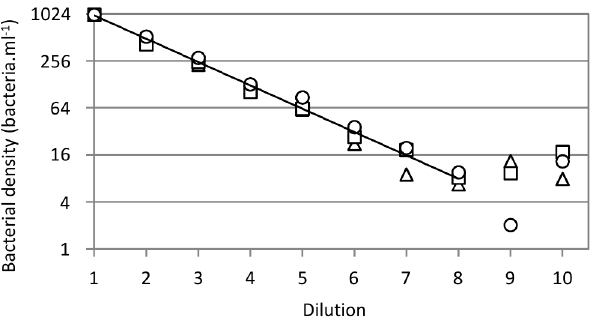
Fig 3. Determination of minimal detectable cell count of infected E . coli TD2158. Serial 2-fold dilutions from 10 3 to 2 bacteria.ml -1 are numbered from 1 to 10. Each dilution was infected with the HK620::P rrnB - gfp phage and incubated for 1 hour at 30°C. The bacterial cell count was determined using the A50 Apogee flow cytometer. This assay was repeated three times and each replicate is represented with the following symbols: triangle, replicate 1; square, replicate 2; circle, replicate 3. The trend line obtained from the mean of normalized values (1,000 cells.ml -1 starting cell count) is drawn on the chart. The correlation coefficients (dilutions from 1 to 8) were 0.993, 0.995 and 0.997 for replicates 1, 2 and 3,